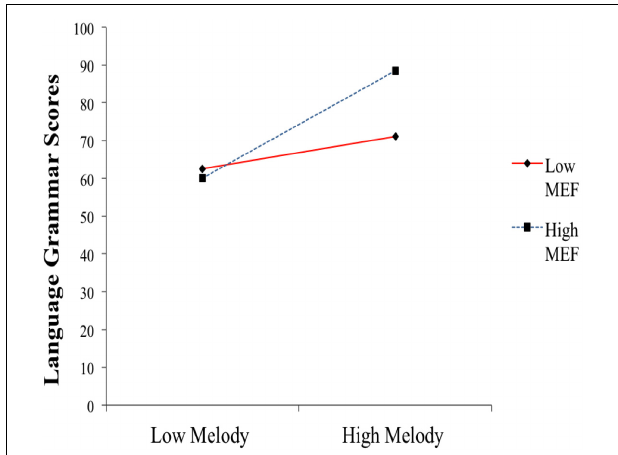
FIGURE 4 | Interaction between Musical Experience in the Family and Melody Perception in predicting language grammar scores.